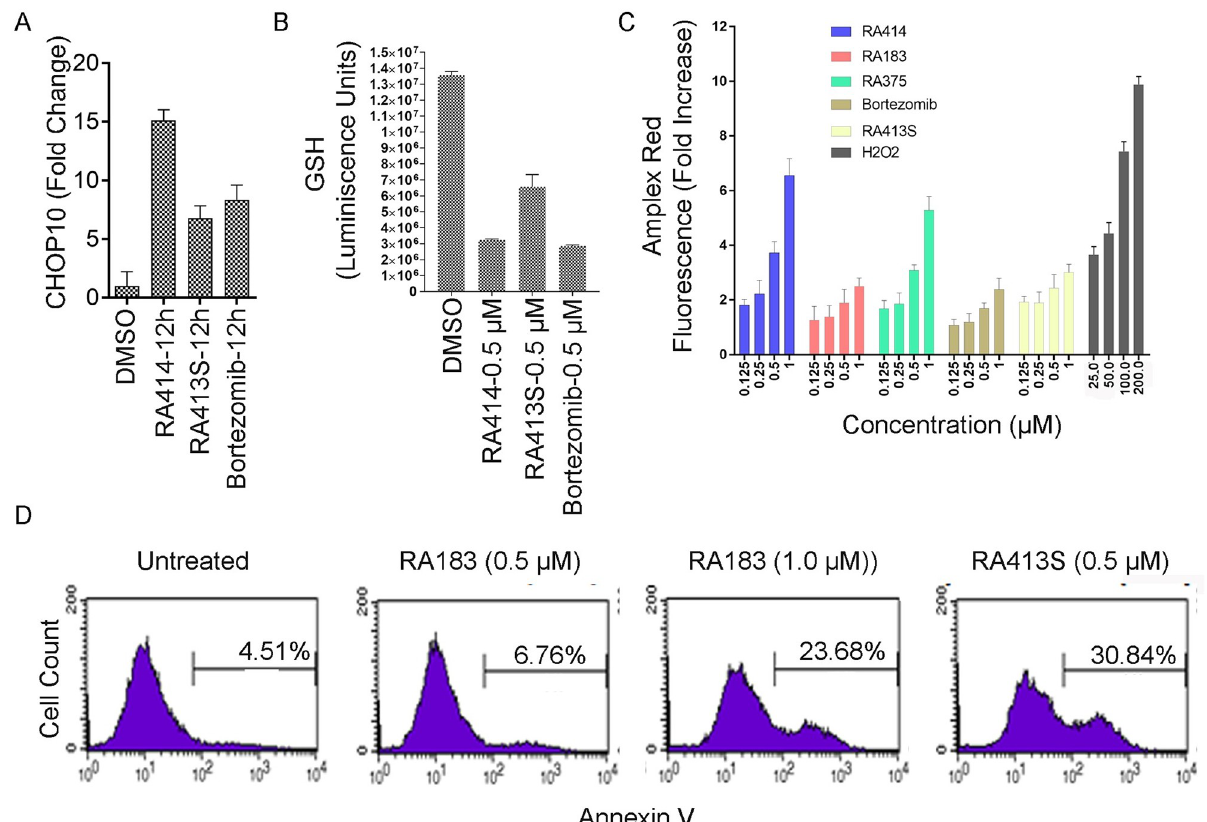
Fig 6. RA413S and RA414 induce both ER and oxidative stress triggering apoptosis. (A) ES2 cells treated with compounds (0.5 μ M) for 12 h and CHOP-10 mRNA levels, an ER stress marker, was analyzed by qRT-PCR. (B) ES2 cells were treated with compounds for 12 h and the total GSH level was assayed. (C) ES2 cells treated for 12 h with compounds (or as a positive control, H 2 O 2 ) at the indicated doses, and then ROS levels were measured by adding Amplex Red and HRP. (D) To examine the early onset of apoptosis, ES2 cells were treated with compounds at indicated doses for 12 h then re-suspended in 100 μ L binding buffer with 5 μ L of Annexin V-PE and 5 μ L of 7-AAD. After a 15 min incubation at RT, the cells were analyzed by flow cytometry using a FACSCalibur and CellQuest software.